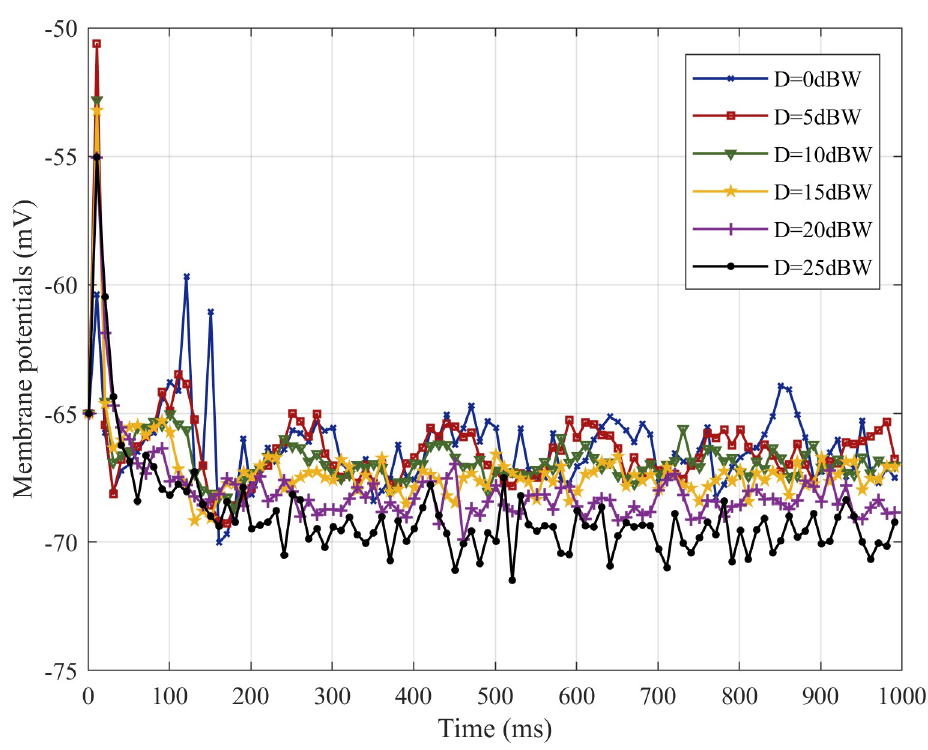
Fig 8. The change in the membrane potentials before and after noise stimulation.